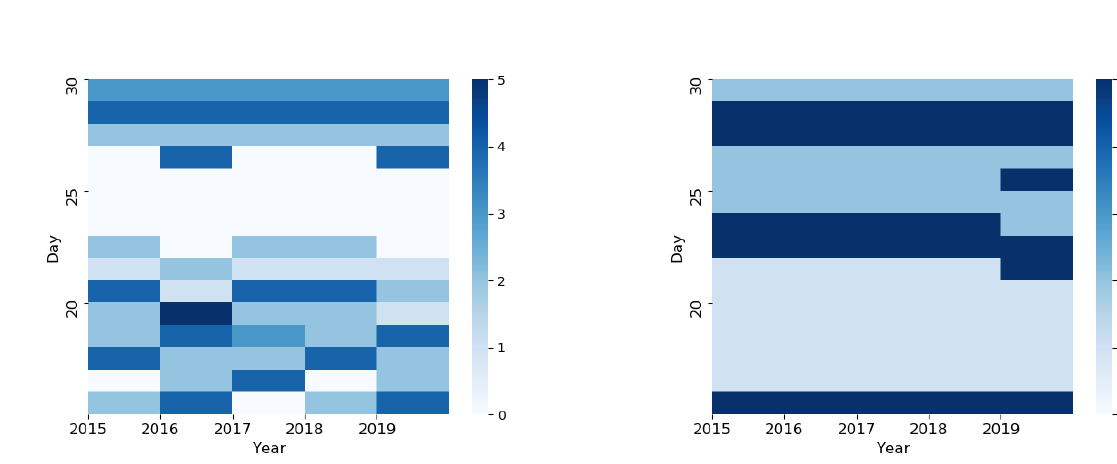
Figure 7: Clustering output for NO 2 for last 15 days in Q 2 over 2015 to 2019.